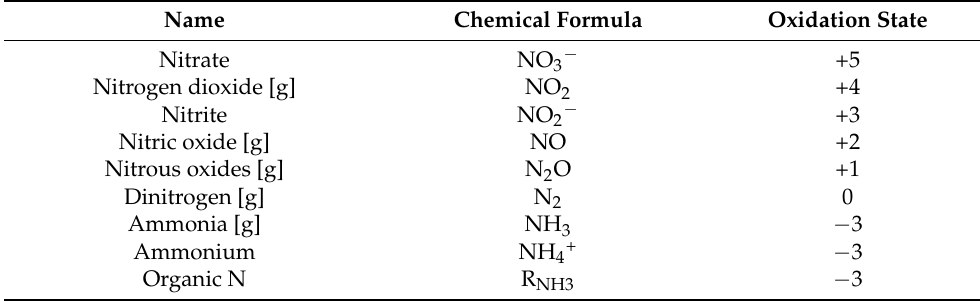
Table 2. Main Forms of Nitrogen in soils and their Oxidation